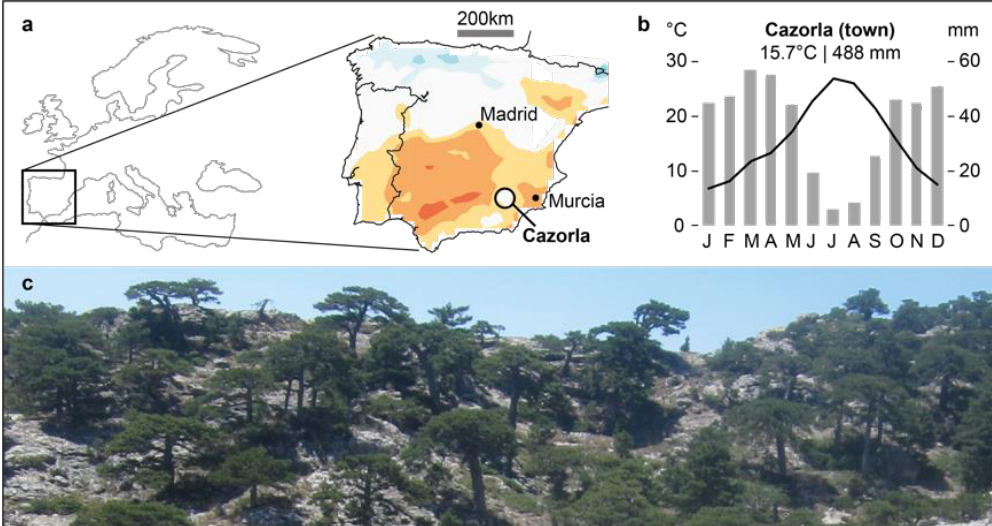
Figure 1. Study site and climate. ( a ) Location of the Cazorla Natural Park (CNP) in southern Spain. Colors indicate mean summer temperatures exceeding 24 °C in yellow, 26 °C in orange, and 28 °C in red. ( b ) Climate diagram of the station located in the town of Cazorla ~10 km northeast but 1000 m below the black pine sampling site. ( c ) Photograph of the tree site in the CNP.